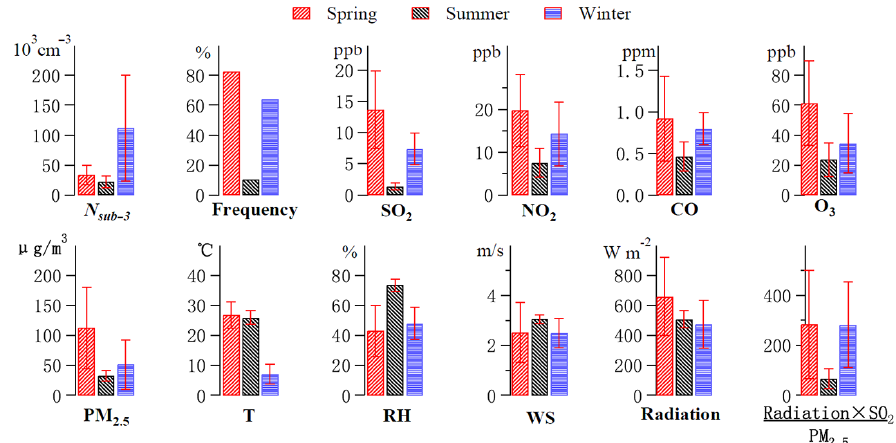
Figure 4. Mean and standard deviation of event-averaged N sub-3 , anthropogenic trace gases (SO 2 , NO 2 , CO and O 3 ), PM 2 . 5 , and meteoro- logical variables (temperature, RH, wind speed, WS, solar radiation, and radiation × SO 2 / PM 2 . 5 ) for nucleation events in spring ( n = 17), summer ( n = 3) and winter ( n = 14). Nucleation frequency (the percentage of event days out of total measurement days) was also